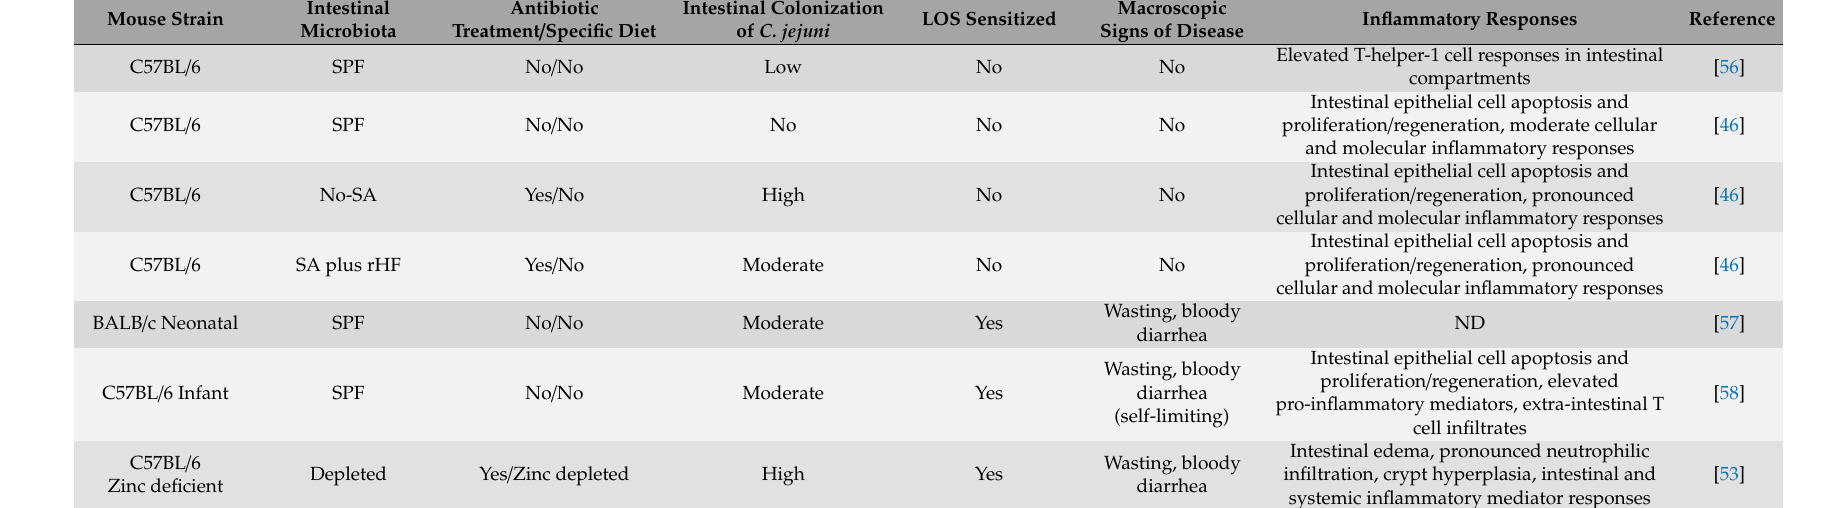
Table 1. Murine models of C. jejuni infection applying conventional and microbiota depleted wildtype